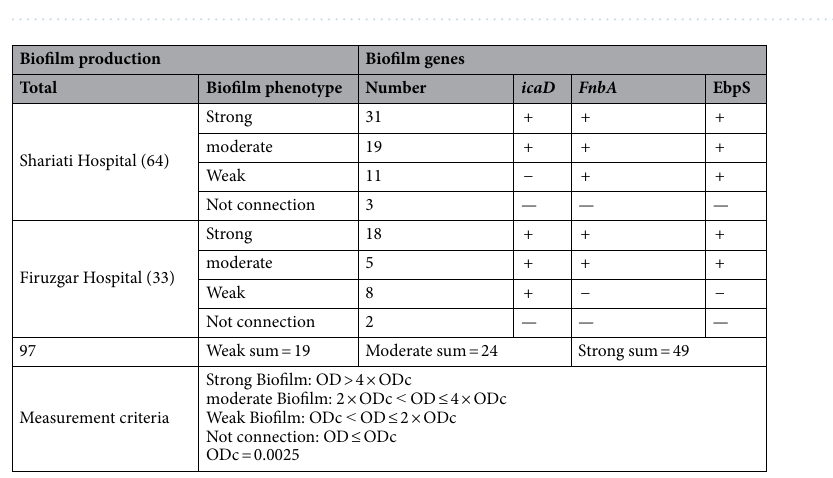
Figure 2. ( A ) The rate of controlled drug release in various formulations of Niosome-encapsulated Imipenem compared to free Imipenem. ( B ) the impact of temperature on average size and encapsulation efficiency ( C ) of F1 and F2 formulation of Niosome-encapsulated Imipenem (ns, p > 0.05, ** p < 0.01, * p < 0.05. n = 3).